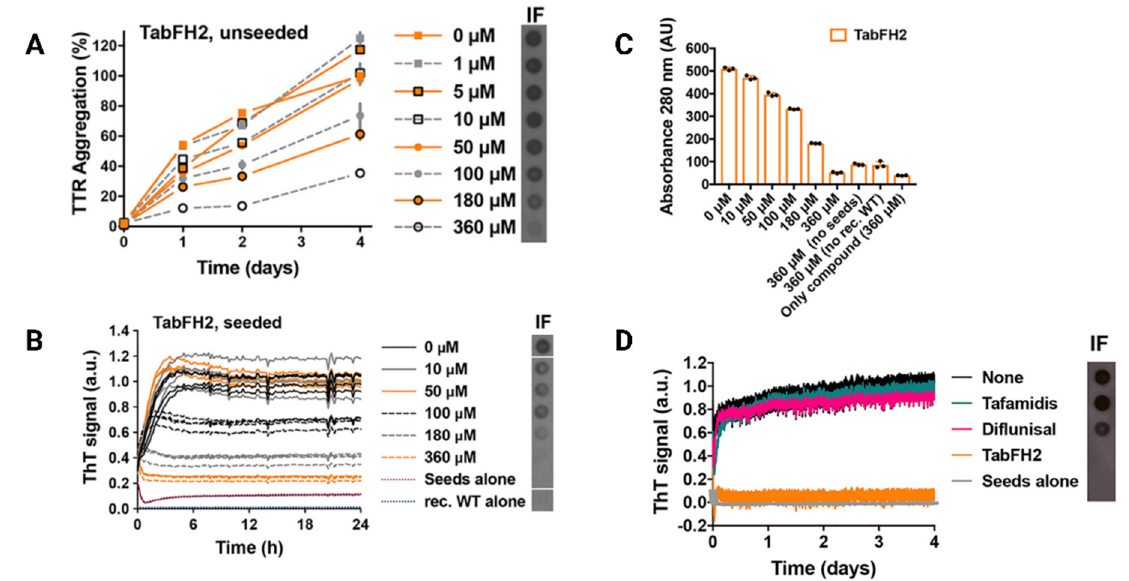
Figure 4. TabFH2 inhibits TTR aggregation and amyloid seeding caused by ATTR ex vivo seeds. ( A ) Inhibition of TTR aggregation by TabFH2 in the absence of seeds, measured by absorbance at 400 nm. Increasing amounts of TabFH2 were added to 1 mg/mL of recombinant WT TTR, and the sample was incubated for 4 days at pH 4.3. Absorbance measured after 4 days of incubation in the absence of TabFH2 was considered 100% aggregation, because no soluble TTR was detected (n = 3). Error bars, S.D. Right inset, anti-TTR dot-blot of insoluble fractions (IF) collected by centrifugation after 4 days of incubation. ( B ) Inhibition of amyloid seeding by TabFH2 at pH 4.3, monitored by ThT fl uo- rescence. Increasing amounts of TabFH2 were added to 0.5 mg/mL of recombinant WT TTR and 30 ng/L of ATTR-D38A seeds. All replicates are shown (n = 4). a.u., arbitrary units. Inset, anti-TTR dot- blot of IF collected by centrifugation after 24 h of incubation. All samples were spo tt ed onto the same nitrocellulose membrane and subjected to the same procedure; splicing was needed for presentation purposes. ( C ) Protein content quanti fi cation of the insoluble fractions collected from B, measured by 280 nm absorbance. AU, absorbance units. The reduction in ThT fl uorescence observed in B cor- relates with the decrease in total protein and TTR content in the IF, shown in the right inset of B. ( D ) Comparison of inhibition of amyloid seeding by tafamidis, di fl unisal, and TabFH2 when incubated for 4 days, measured by ThT fl uorescence. A 360 M inhibitor was added to 0.5 mg/mL of recombi- nant WT TTR and 30 ng/L of ATTR-D38A seeds (n = 3). Error bars, S.D. Inset, anti-TTR dot blot of IF collected by centrifugation after 4 days of incubation. Modi fi ed with permission from L. Saelices et al., 2019 [60].